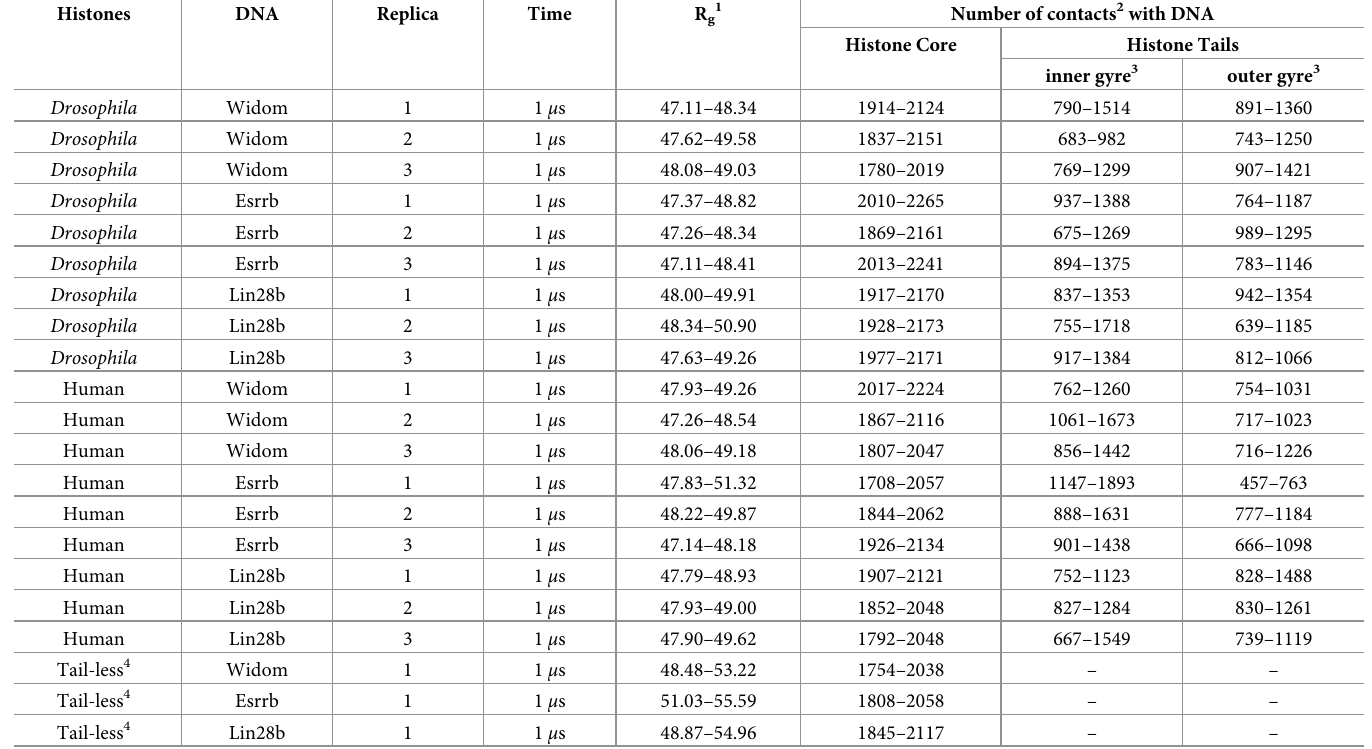
Table 1. Overview of the simulations